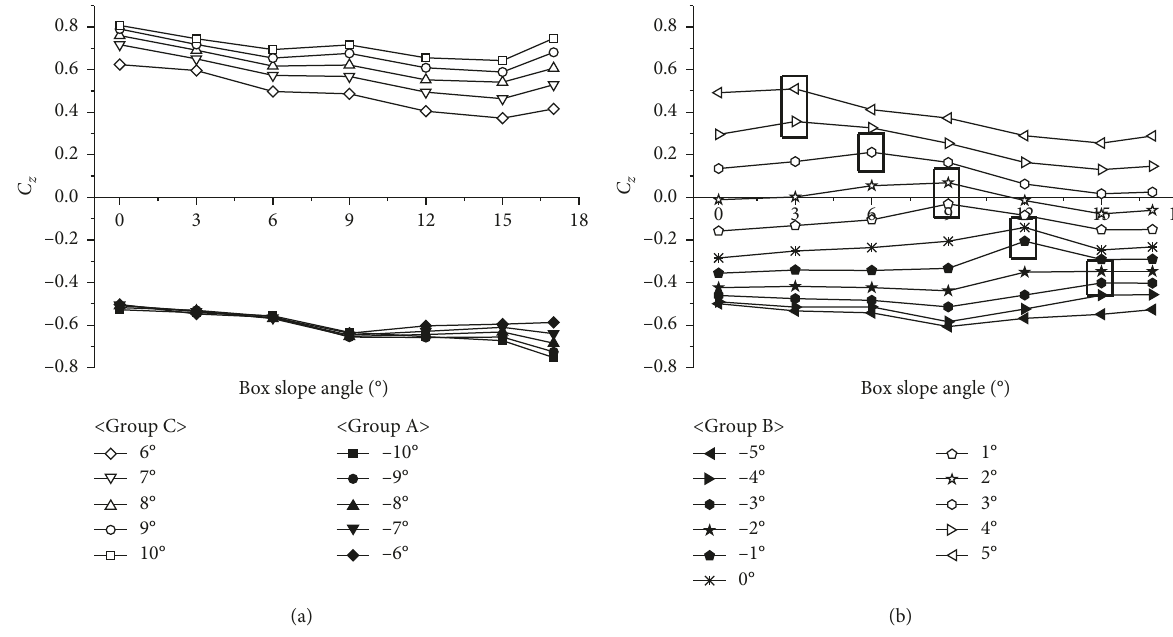
Figure 16: C z vs. box slope angle for various AOA: (a) groups A and C; (b) group